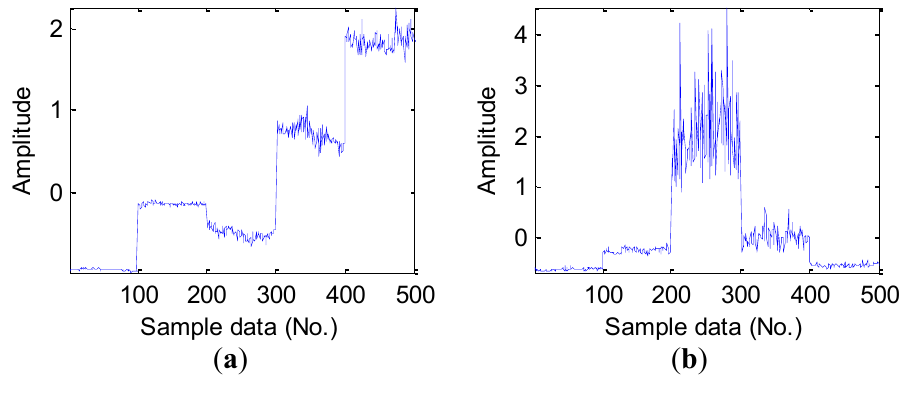
Figure 6. The normalized time domain features in the D_IRF dataset: ( a ) RMS. ( b ) kurtosis value. ( c ) peak-peak value. ( d ) impulse factor. (Note: Sample data No. 1–100, 101–200, 201–300, 301–400, 401–500 represent Normal, IRF07, IRF14, IRF21 and IRF28